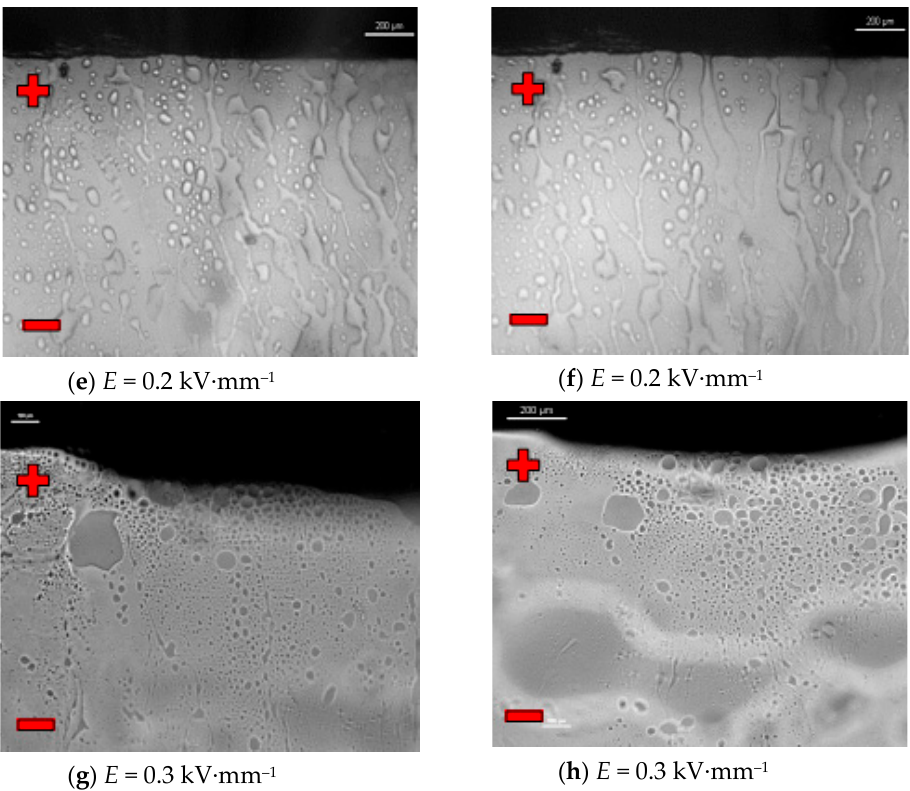
Figure 15. ( a – h ): Mixture GP1 + CJ001 in an electric field observed under Nikon Eclipse LV100D polari-zing microscope.